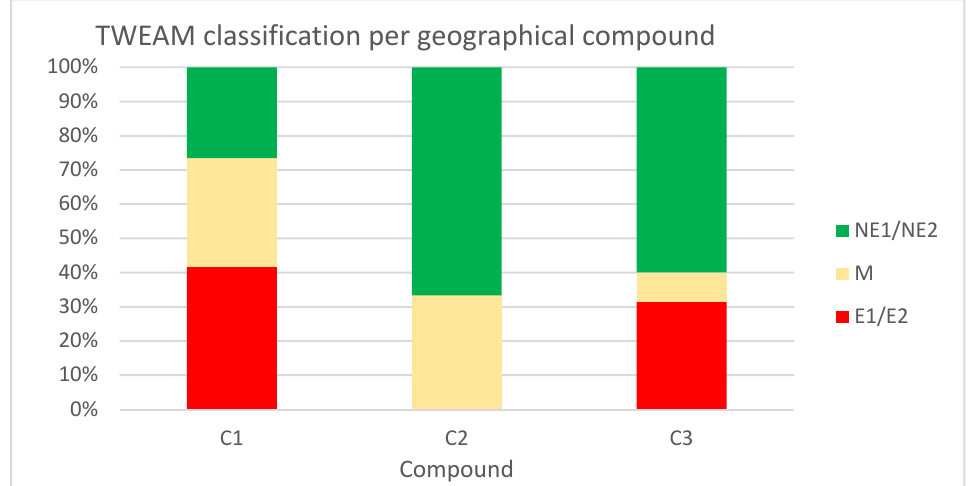
Figure 6. TWEAM classification for each compound C1: Northern Adriatic compound; C2: Apulian compound; and C3: Sardinian compound. Data are expressed as a percentage of stations in each class.